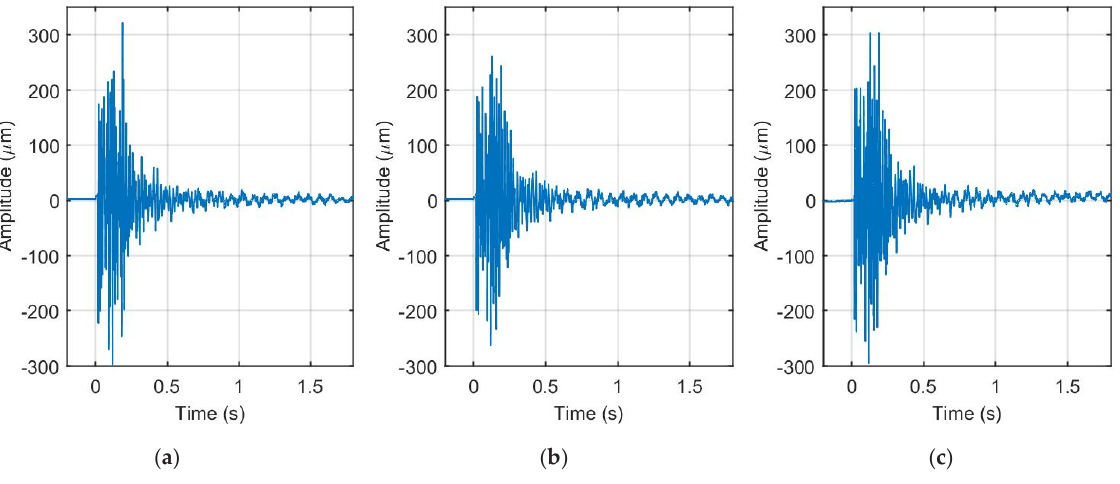
Figure 11. Impact force time responses: ( a ) Without defect; ( b ) One defect; ( c ) Two defects.